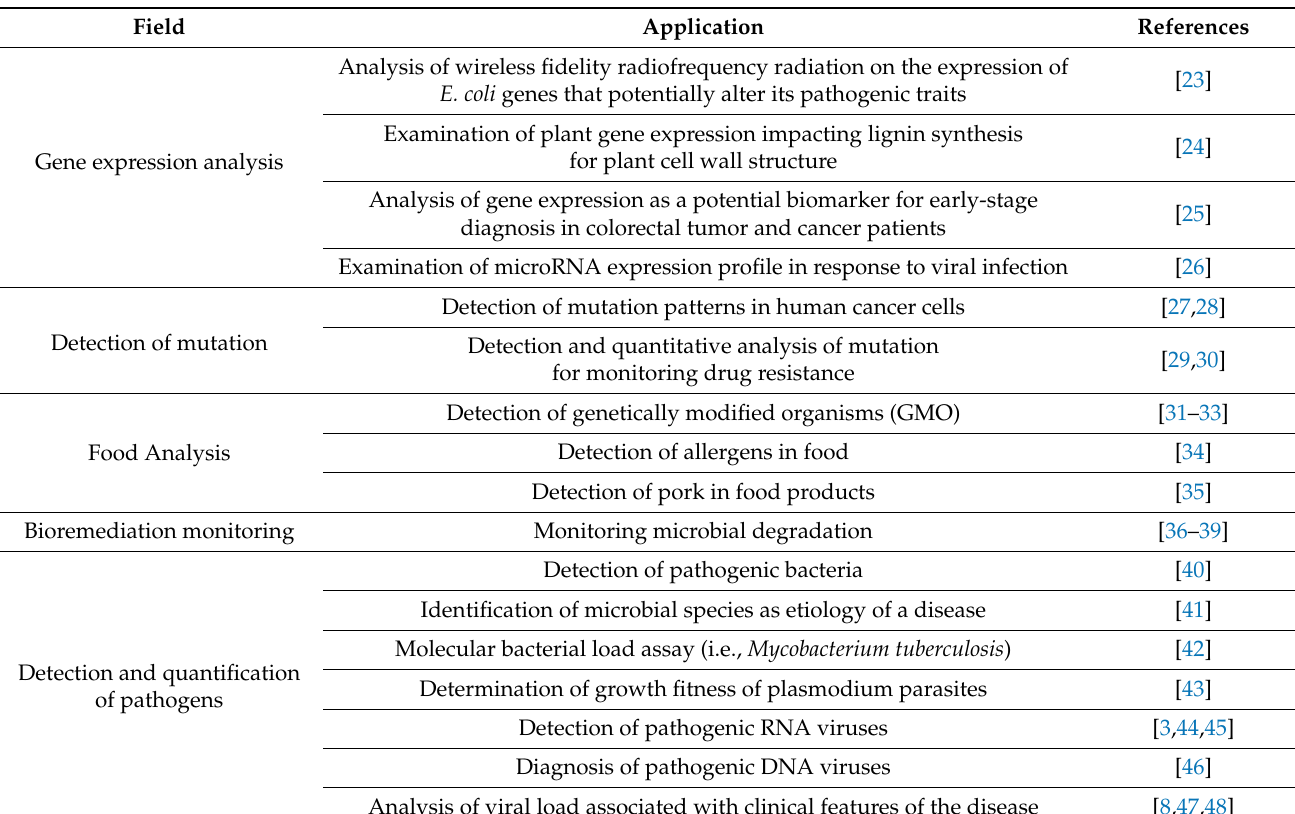
Table 1. Examples of application of real-time polymerase chain